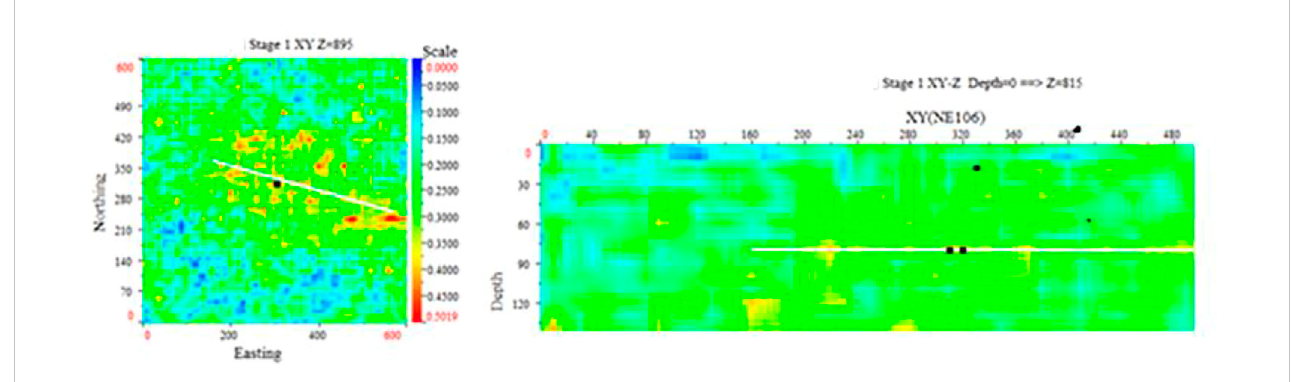
FIGURE 8 Total effect of fracturing fracture distribution in well ZHSY-1.